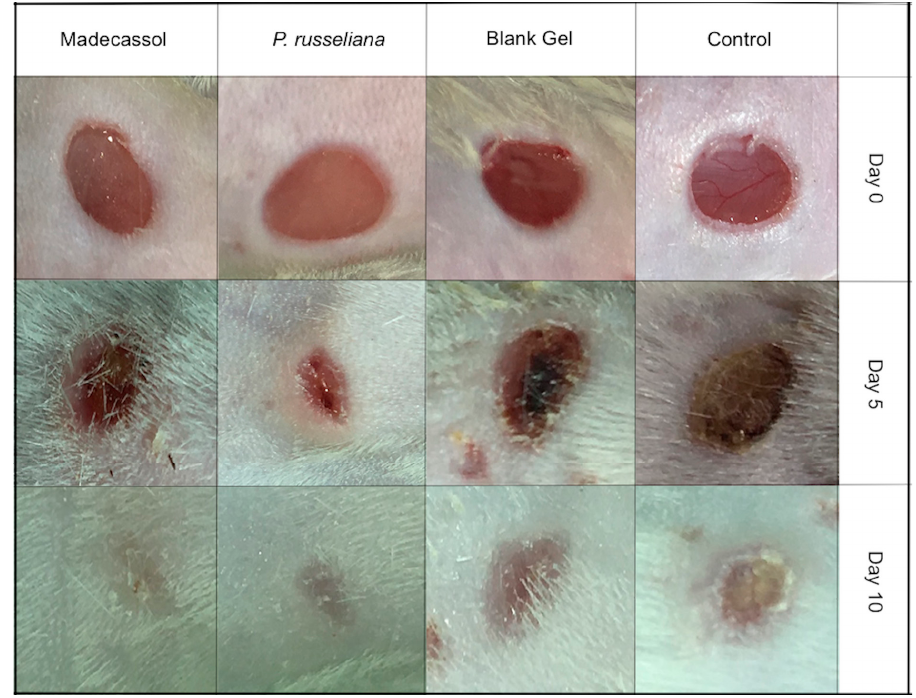
Figure 4. Macroscopic visualization of test samples: control, blank gel, Madecassol, P. russeliana extract test groups at days 0., 5. and 10.